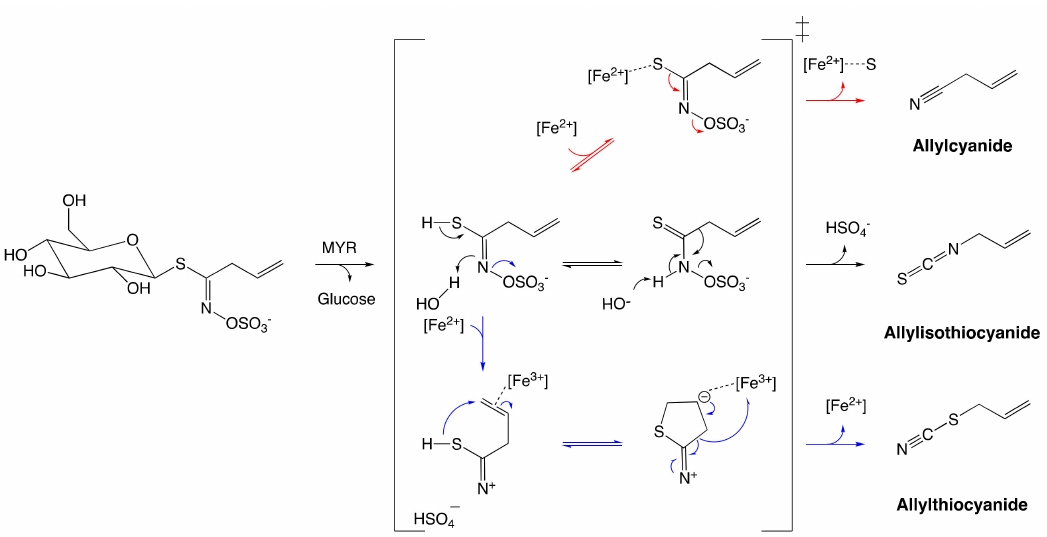
Figure 11. Reconfiguration of unstable allylglucosinolate aglucone upon myrosinase-catalyzed hydrolysis. The black arrow pathway shows the formation of allylisothiocyanates employing spontaneous Lossen arrangement. The Blue arrow pathway shows the formation of allylthiocyanate assisted by protein specifier. The red arrow pathway indicates the formation of allylcyanide assisted by protein specifier. The figure was adapted from Eisenschmidt-Bönn et al.